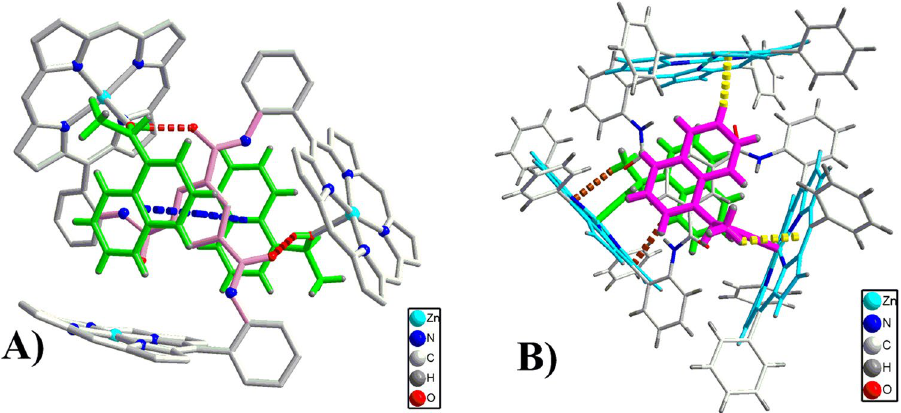
Figure 3. Crystal structure of [Zn 3 -BTATPP]·( 2S ) 2 . (mol A). ( A ) Showing hydrogen bonds (red dash line) and π - π interactions (blue dash line). Some phenyl groups at meso -positions and all hydrogen atoms except those for the guest are omitted for clarity. ( B ) Showing CH··· π interactions (yellow dash line and brown dash line).